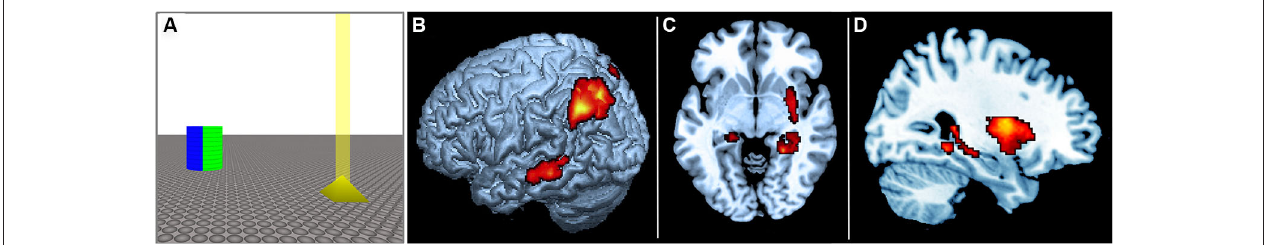
environments and differed only in the instructions to the participants (i.e., coordinate task: “Remember the distance”; categorical task: “Remember the sector”). (B) Rendered image of left hemisphere showing corresponding fMRI data. (C) Axial view. (D) Sagittal view. There was greater left posterior parietal activity during the encoding of categorical spatial relations, and greater right hippocampal activity during the encoding of coordinate spatial